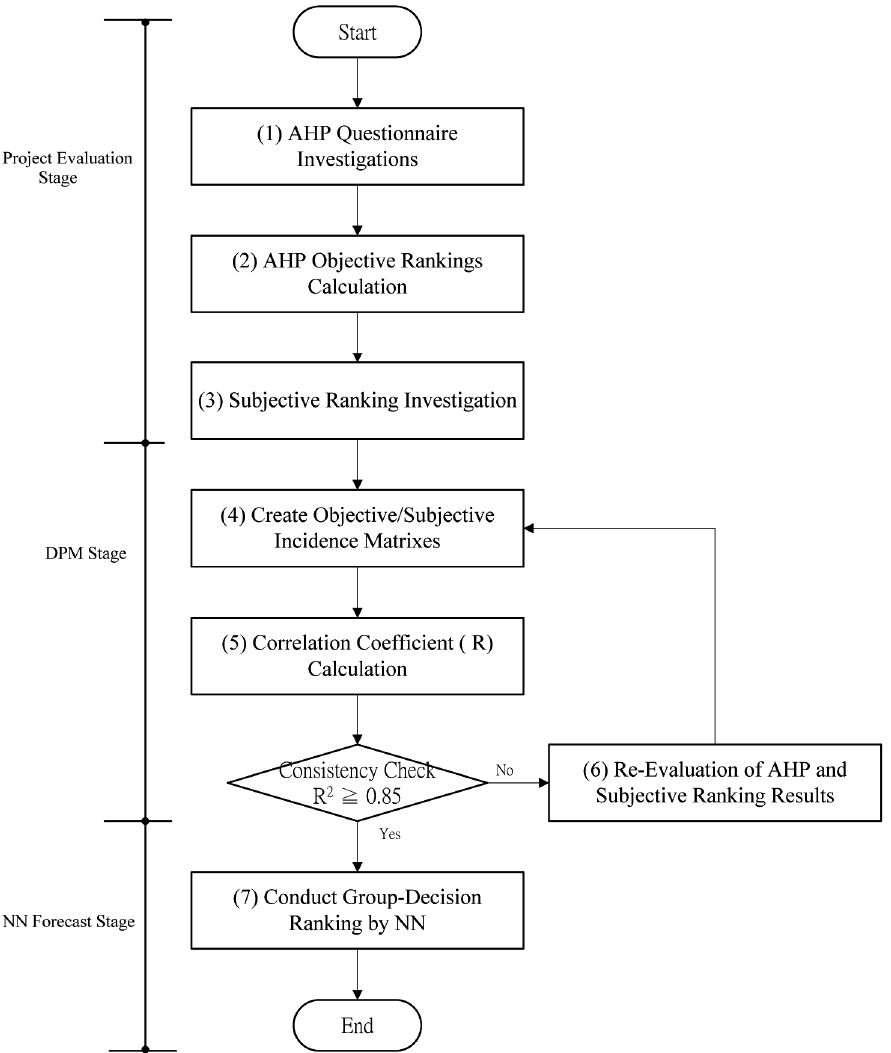
Fig. 3. Process of the AHP/DPM/NN railroad project ranking